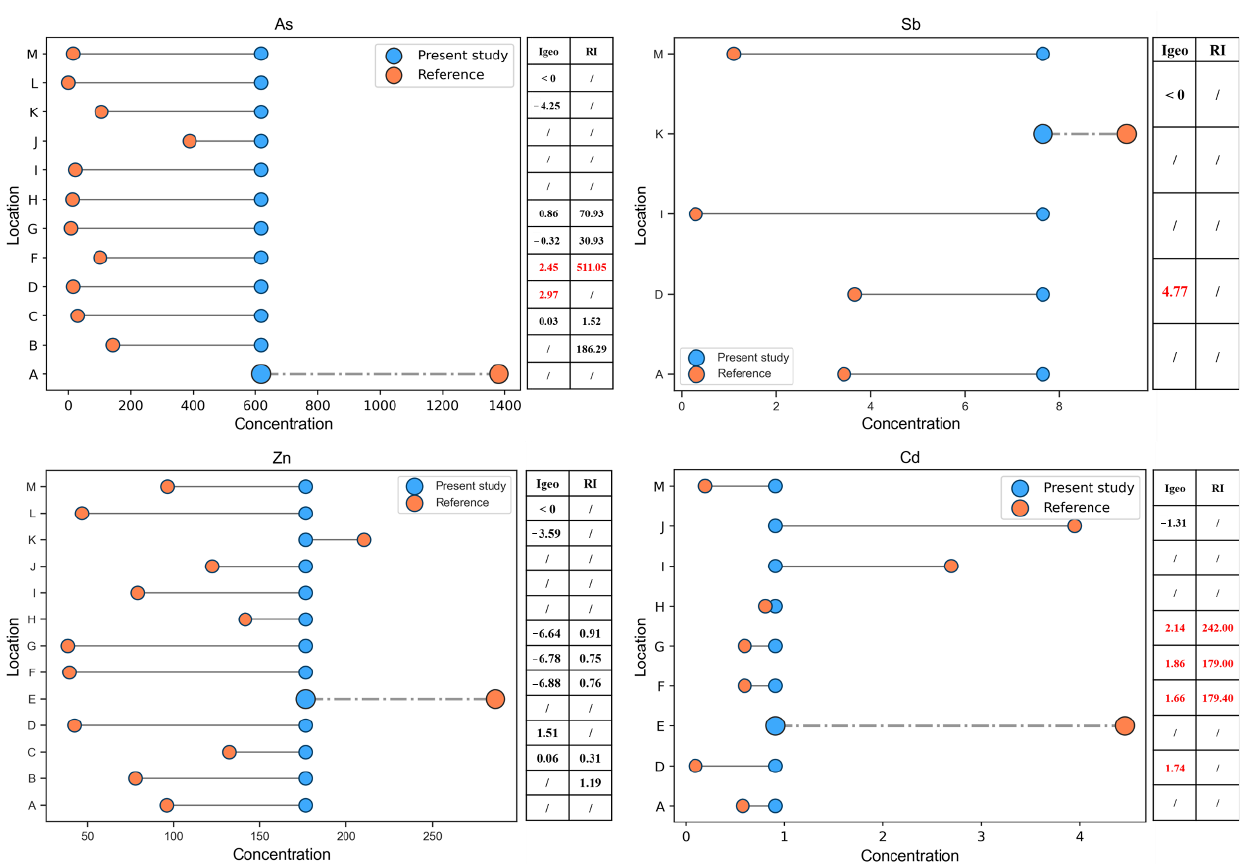
Figure 7. Comparison between the sediments in this study and surface sediments around other gold deposits. Dashed line: represents the value with the largest gap higher than this study’s. Red bold value represents the value exceeding this study. / — Represents missing values in references. A—Orbiel valley (France) [43]. B—Zhaosu River catchment (China) [40]. C—Lom River (Adamawa Cameroon) [64]. D—Anka Gold Mine (Nigeria) [42]. E—Tajum River (Indonesia)